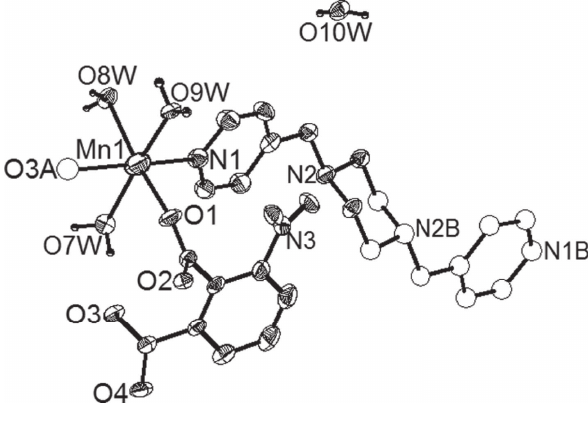
Table 1: Data collection and handling.